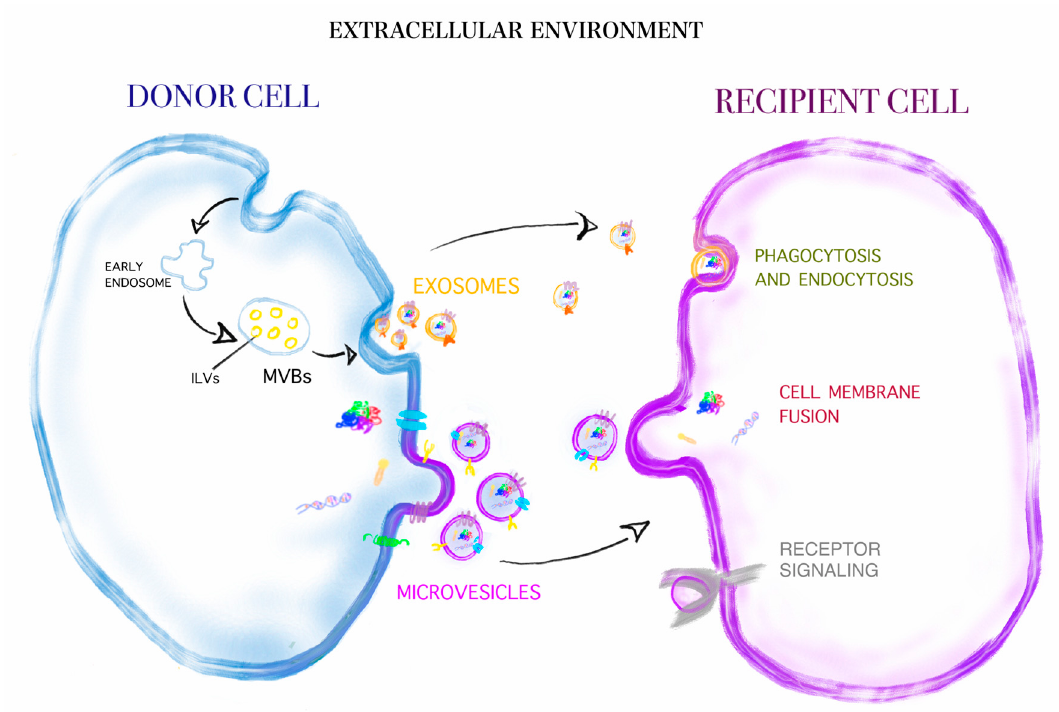
Figure 1. Depicted are the major di ff erences between exosomes (small EVs (sEVs)) and microvesicles (large EVs (lEVs) regarding size and mechanism of release by their cell of origin. Additionally depicted are the major uptake routes of EVs on the recipient cells. Depicted sizes are relative compared to cell size and EV sizes as measured in real.